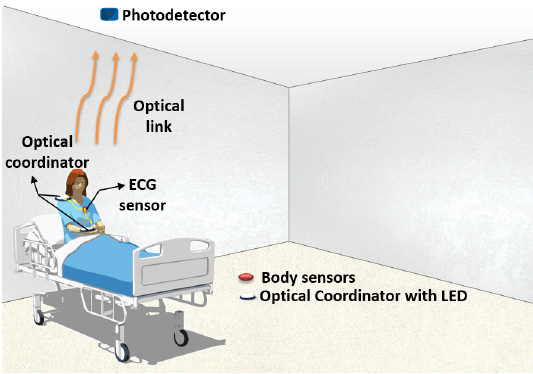
Figure 1. Proposed optical body area network (OBAN) system.